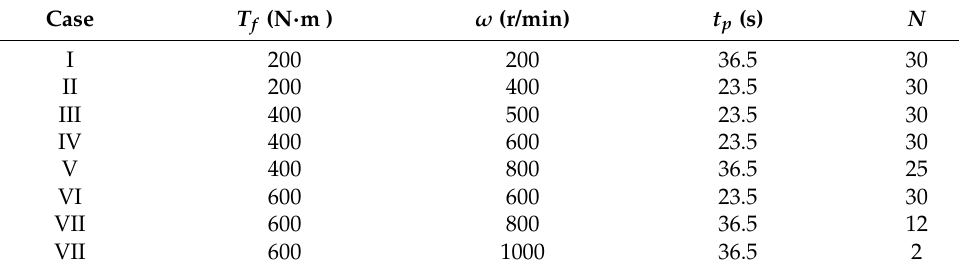
Table 2. Specific parameters under different working